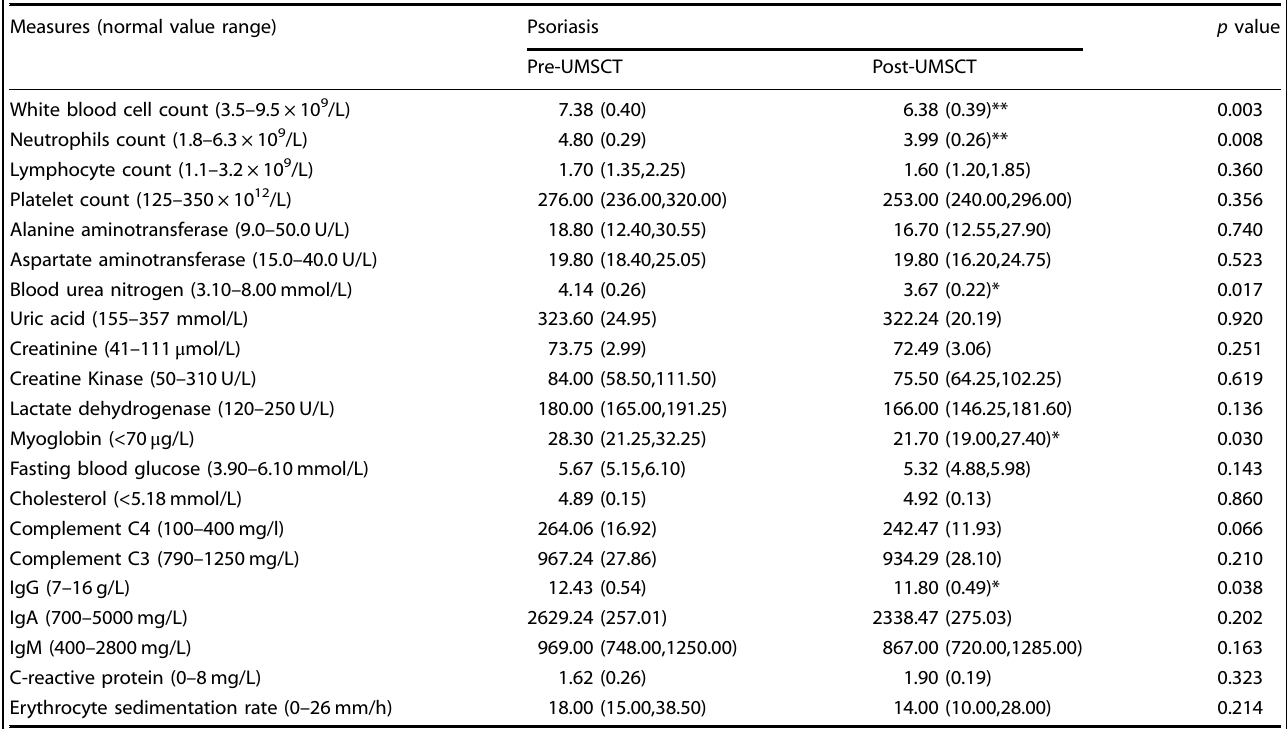
Table 2. Safety evaluation on patients pre- and post- UMSCT